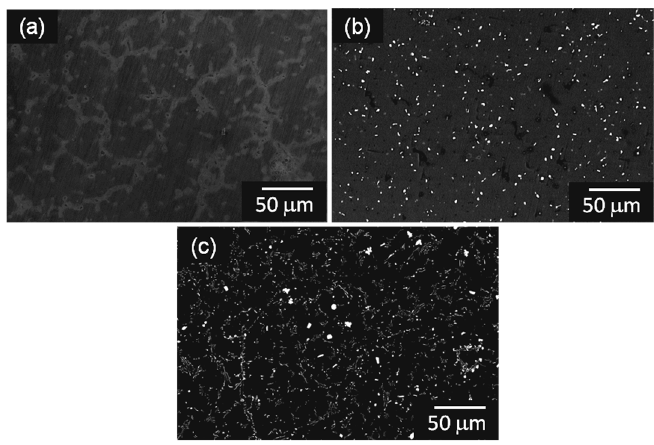
Figure 2. FESEM micrographs of the as-cast alloys showing the distribution of different intermetallic particles in the Mg-Al matrix: ( a ) Mg-4Al, ( b ) Mg-4Al-1Nd, and ( c ) Mg-4Al-4Nd.